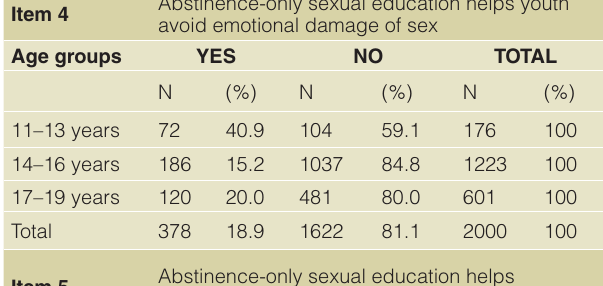
Table 2. Perspective of adolescents according to age group on the advantages of abstinence-only sexual education.